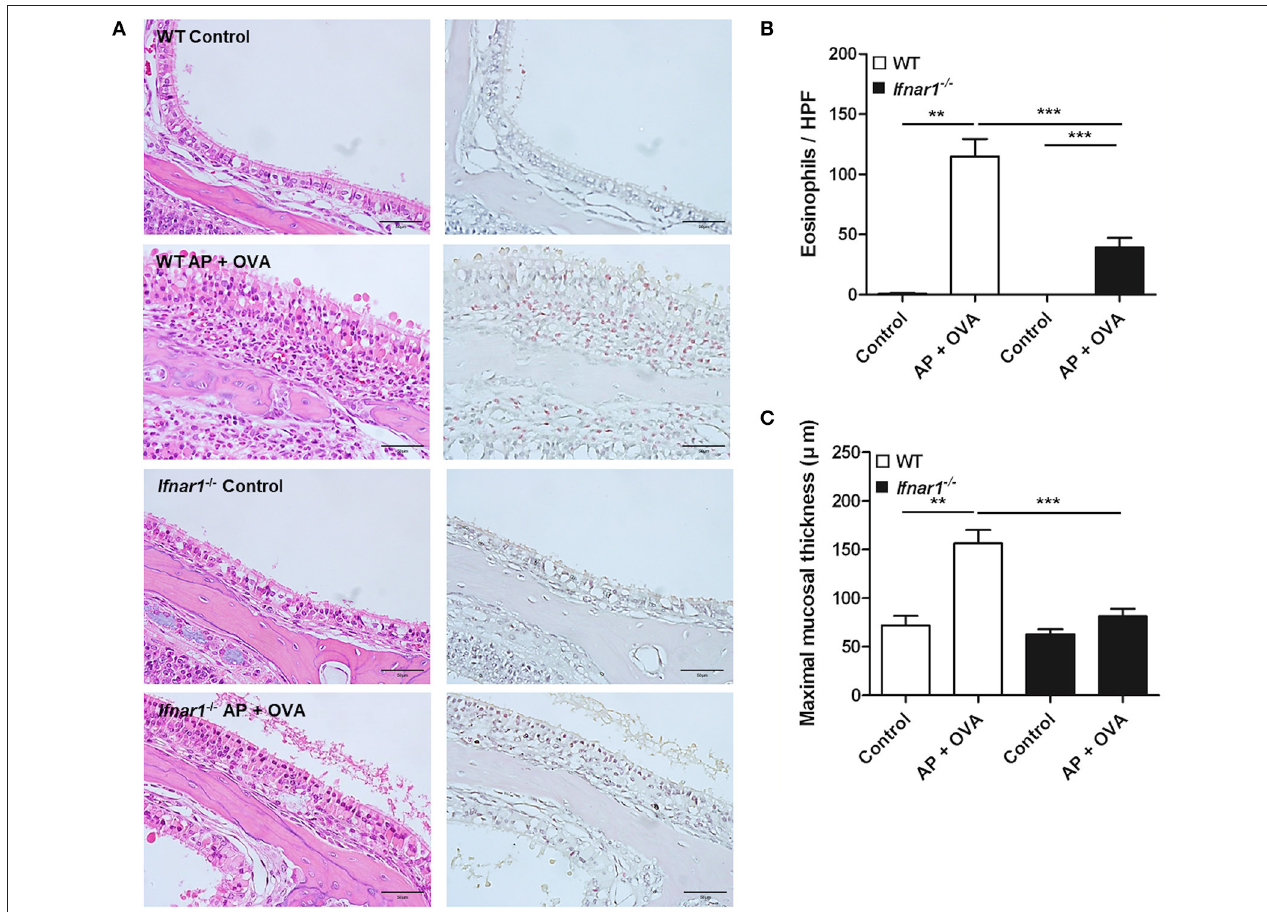
FIGURE 3 | Establishment of eosinophilic chronic rhinosinusitis (ECRS) in WT and IFNAR1 knockout ( Ifnar1 − / − ) mice. (A) Chronic eosinophilic inflammation in the sinonasal mucosa induced by intranasal challenge with Aspergillus oryzae protease (AP) and ovalbumin (OVA) was not complete in the absence of type I IFN signaling. Unlike the wild-type counterpart, epithelial hyperplasia, and inflammatory cells, in particular the eosinophils, definite infiltration was not observed in Ifnar1 − / − AP + OVA challenged mice on hematoxylin and eosin (left) and Sirius red (right) staining for eosinophil (magnification, × 400; scale bar, 50 µ m). (B,C) Eosinophil number and maximal mucosal thickness were less in Ifnar1 − / − AP + OVA challenged mice than in WT AP + OVA challenged mice. ** P < 0.01; *** P < 0.001, repeated measurement ANOVA with Tukey’s multiple comparison test (B,C)